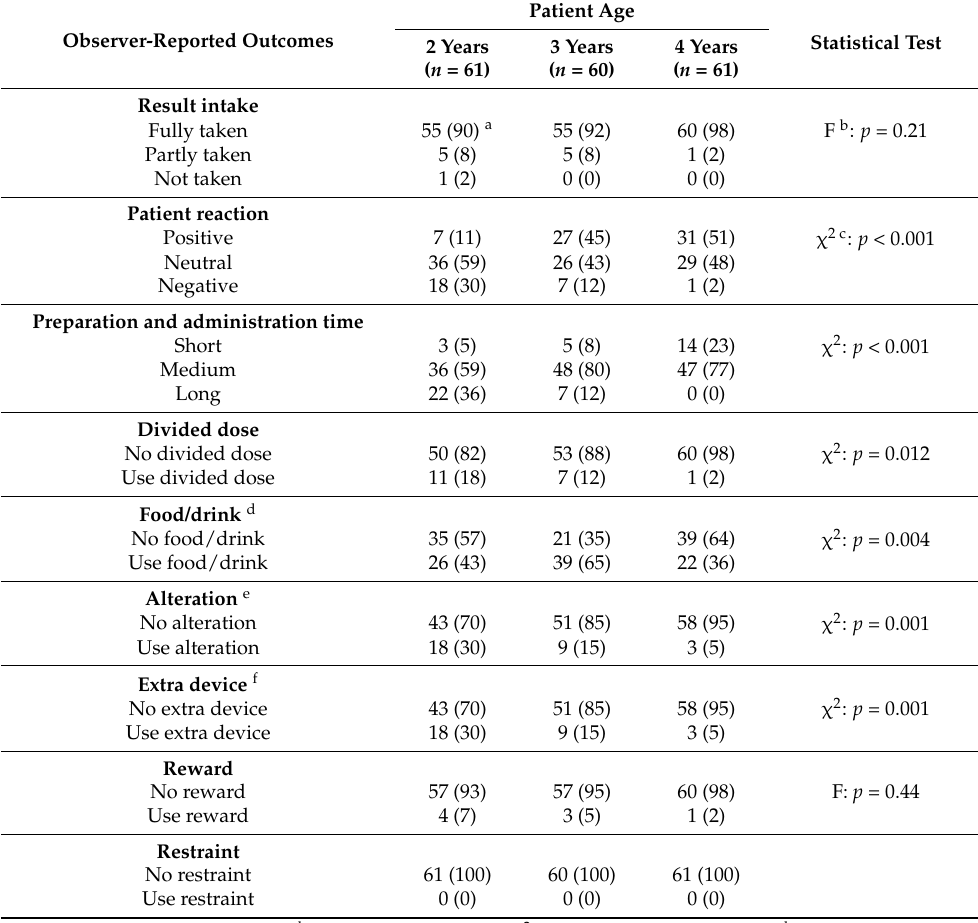
Table 3. Observer-reported outcomes, stratified by patient